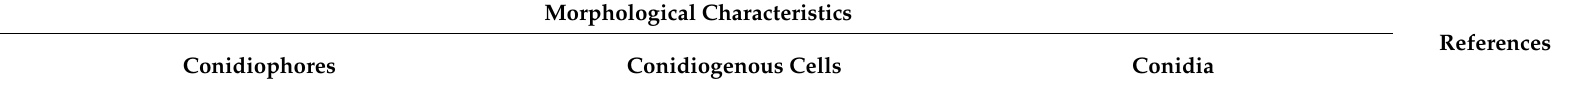
Table 4. Morphological comparison of Periconia byssoides strains isolated from different hosts based on available molecular